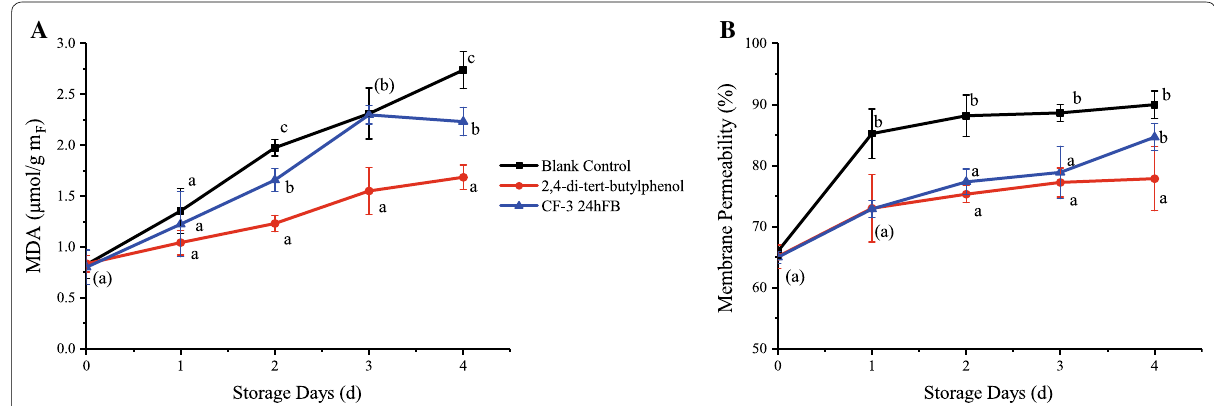
Fig. 5 Influence of different treatments on the amount of MDA ( A ) and membrane permeability ( B ) in vivo during storage. The mean and standard errors in the figure were taken from three replicates, and different letters indicate that different treatments in the same storage days were significantly different ( P < 0.05 ) ( MDA